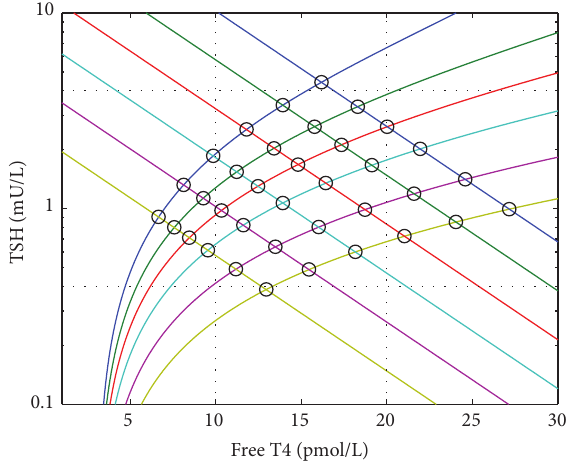
Figure 3: The generation of the T4/TSH set points in a population. The circles represent the different potential set points of different individuals (generated as per Figure 2) that are lying on the intersection points of their individual T4 and TSH